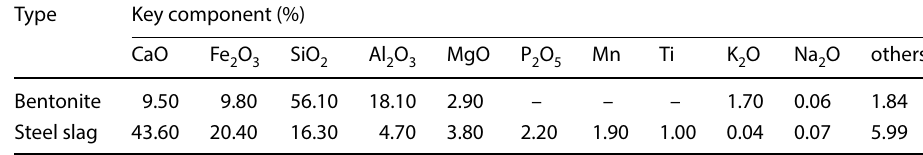
Table 1 Main chemical composition of bentonite and steel slag (Bentonite and steel slag of Liuzhou steel mill in Guangxi,